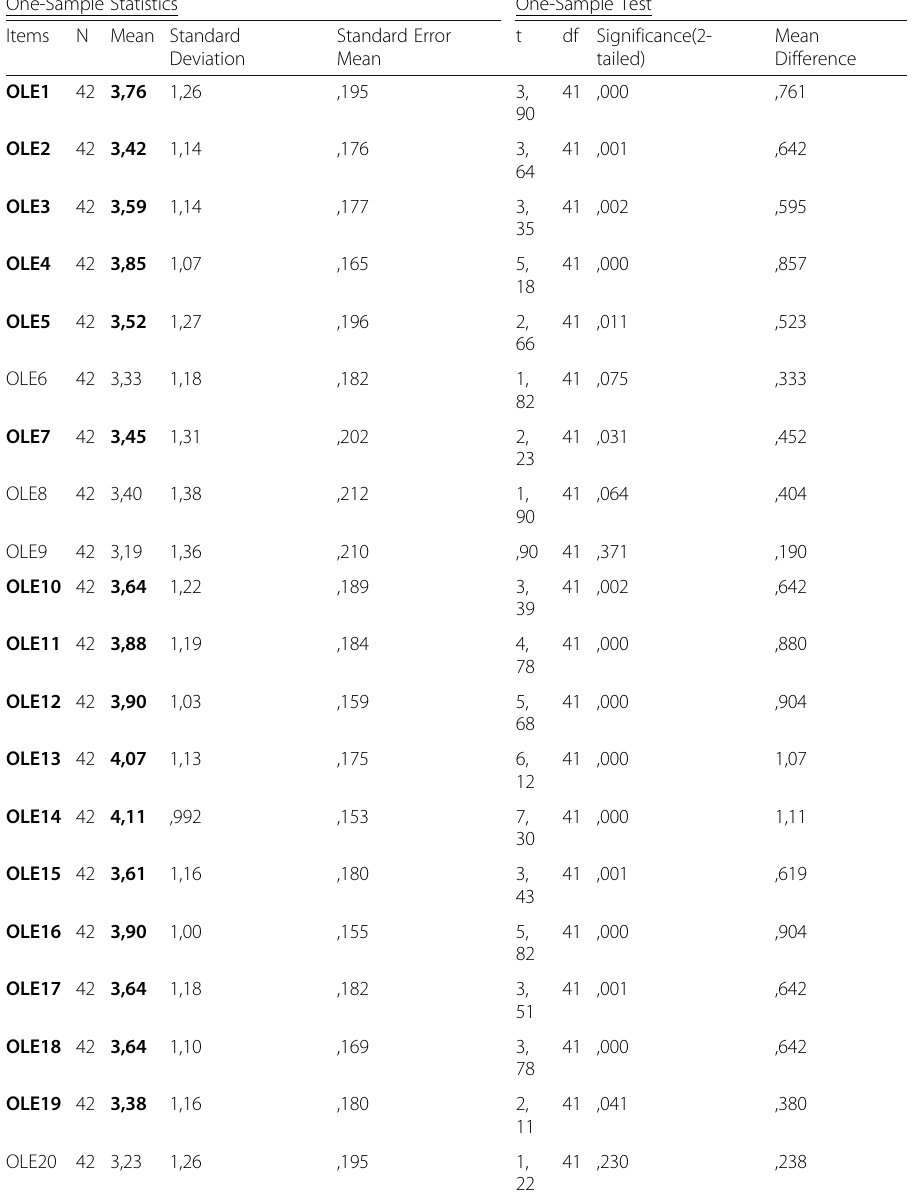
Table 5 One sample t -test results for online learning environment One-Sample Statistics One-Sample